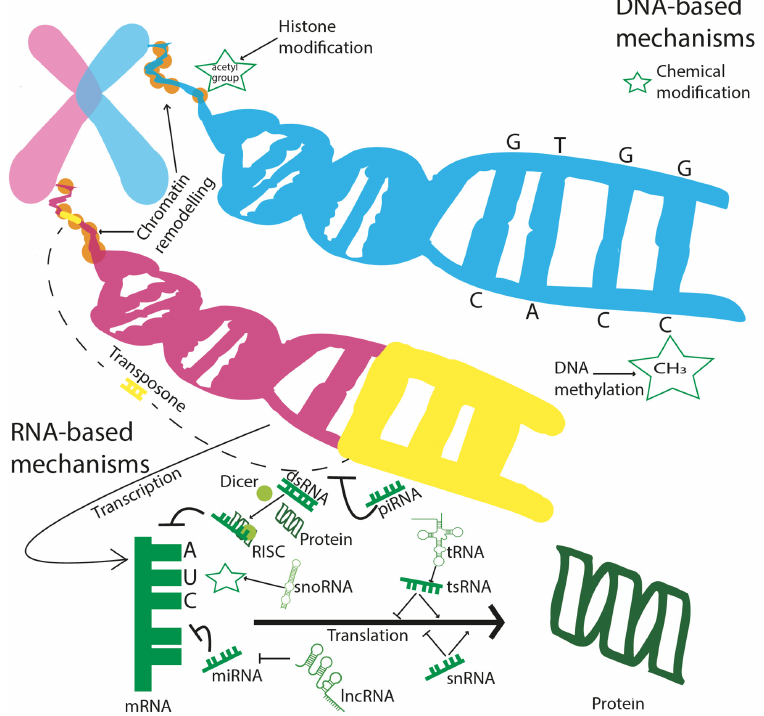
Figure 3. Epigenetic modifications occur on different biological scales. DNA-based mechanisms are concerned with histone modifications, consisting of chemical modifications (i.e., acetylation), DNA methylation, chromatin remodelling, and transposons. RNA-based mechanisms are multiple, com- plex, and still only partially known: miRNA and the RISC complex can induce mRNA degradation; lncRNAs silence the activity of miRNA, while snRNA and tsRNA can both silence, but also induce, mRNA translation to protein. piRNAs can interact with DNA, interfering with the genetic movements of transposons; snoRNAs induce chemical modifications at the mRNA